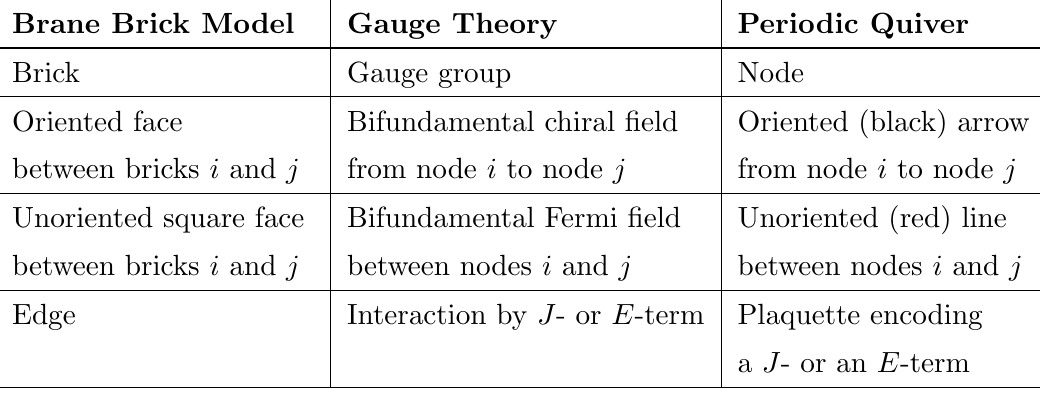
Table 2. Dictionary between brane brick models and 2 d gauge